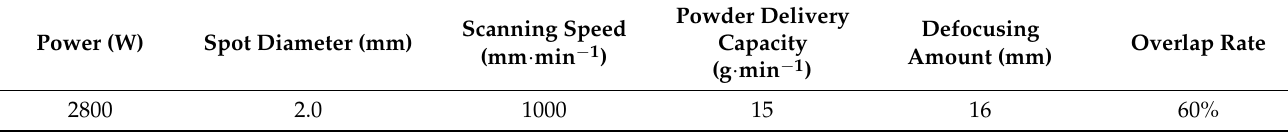
Table 2. Technical parameters of cladding process.